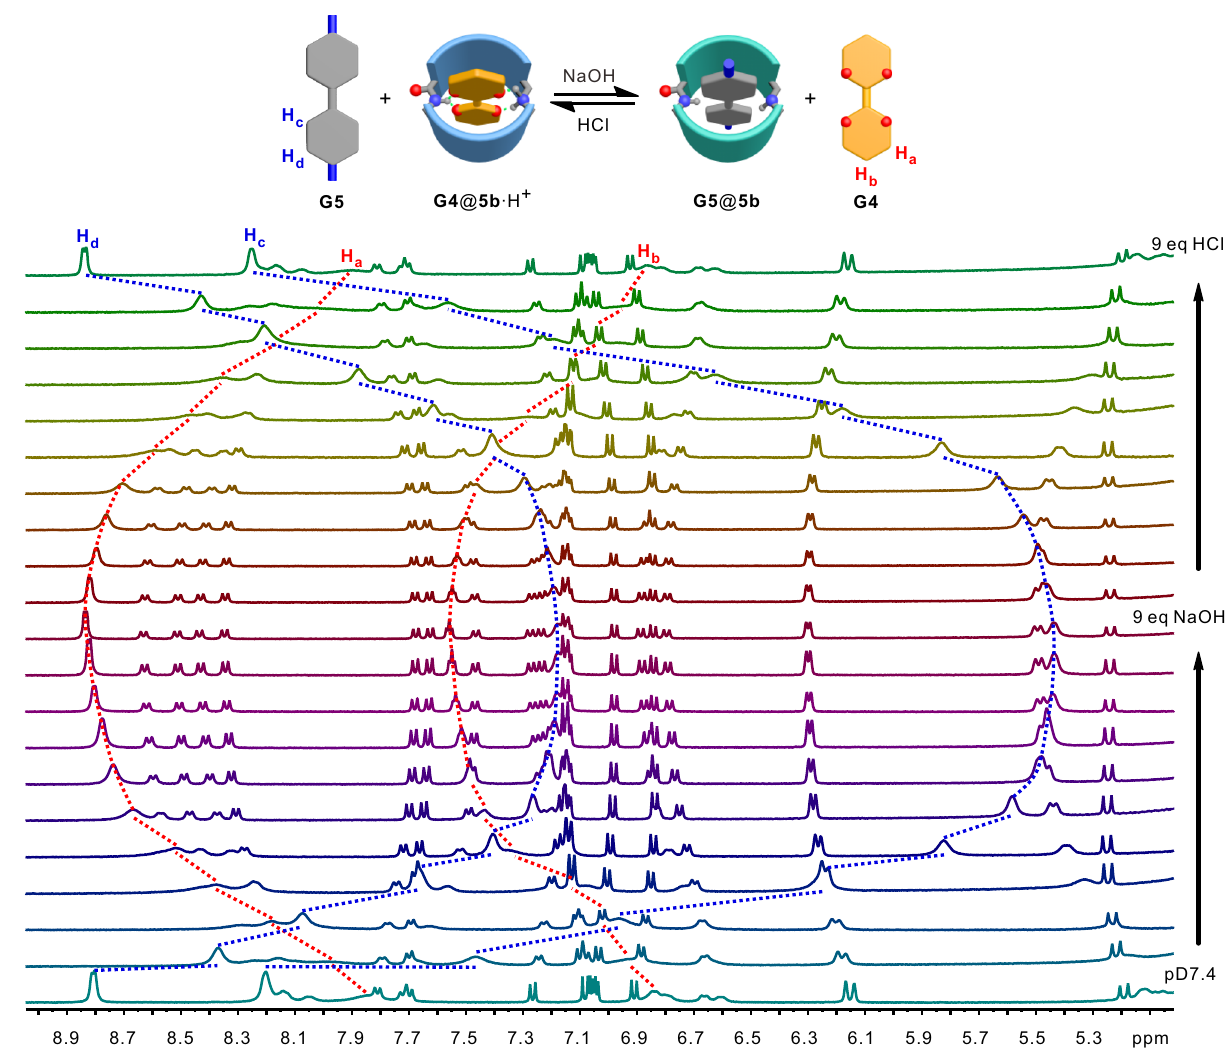
Fig. 6 Switchable bifunctional molecular recognition. Cartoon representation of switchable bifunctional molecular recognition and partial 1 H NMR spectra (500 MHz, D 2 O) of the equimolar mixture of 5b , G4 and G5 at pD 7.4 after gradually adding 9 equivalents of NaOH and then 9 equivalents of